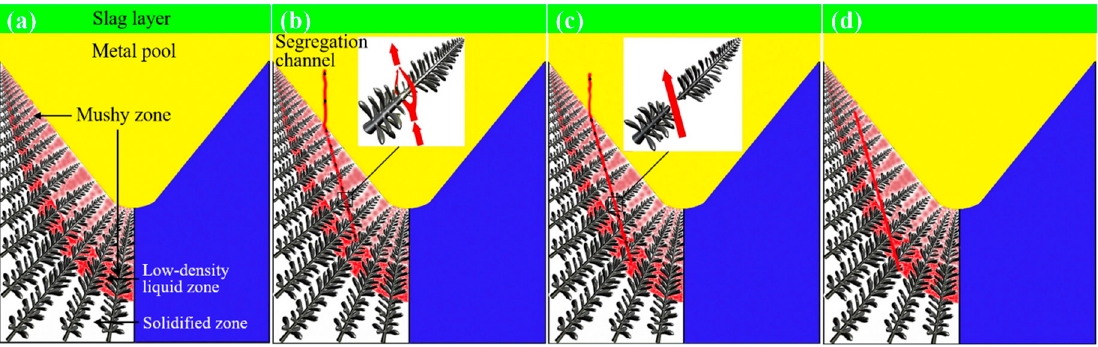
Figure 9. Schematic diagrams of freckle formation during the ESR process. ( a ) gravitational-instability liquid layer, ( b ) erosion of dendritic arm, ( c ) remelting of dendritic arm, ( d ) enclosing of segregated channel.